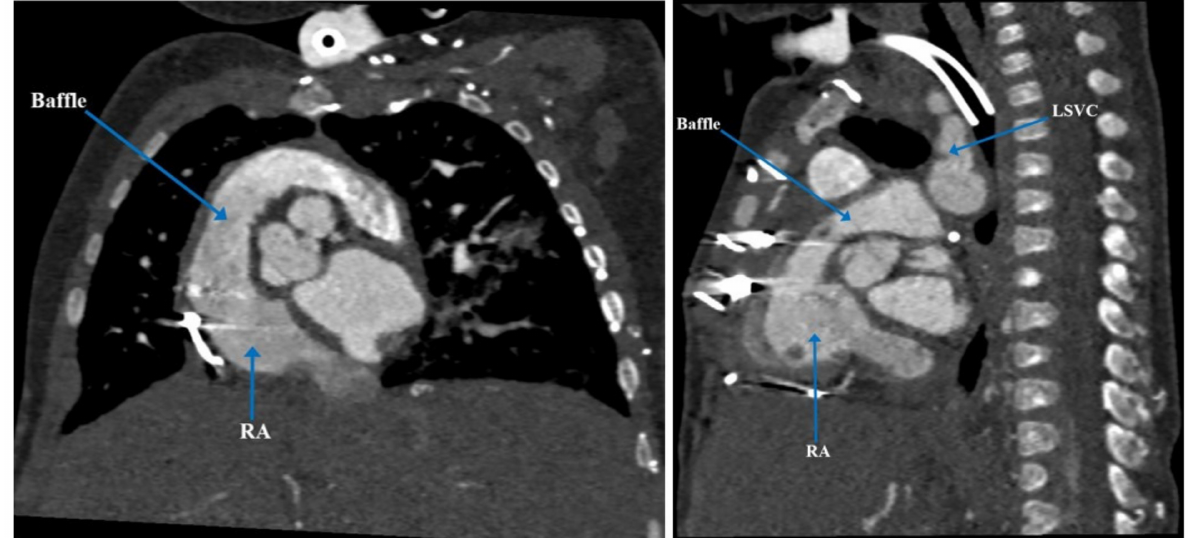
Figure 6. Post-operative computerized tomography coronal and sagittal views demonstrating baffle connection to the right atrium. LSVC = left superior vena cava; RA = right